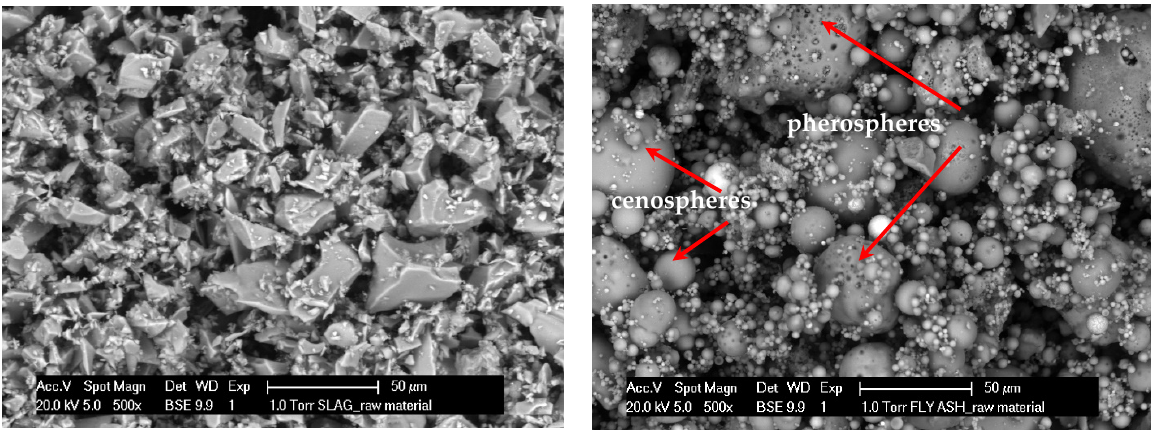
Figure 1. ESEM-BSE images of raw ground granulated blast-furnace slag ((GBFS) ( left )) and fly ash ((FA) ( right )) parti- cles.